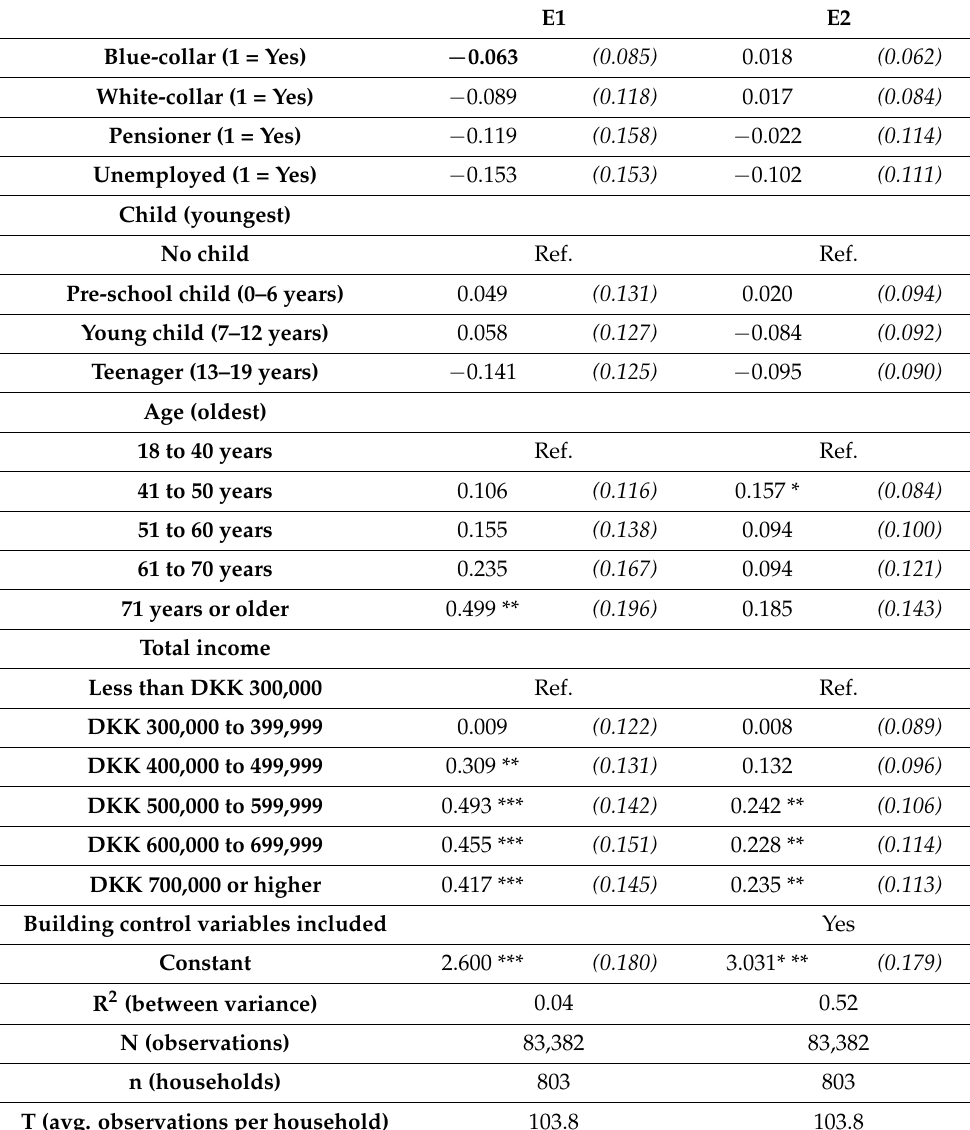
Table 5. Between-effect panel regression model for evening peak (17:00–20:00). Complete table